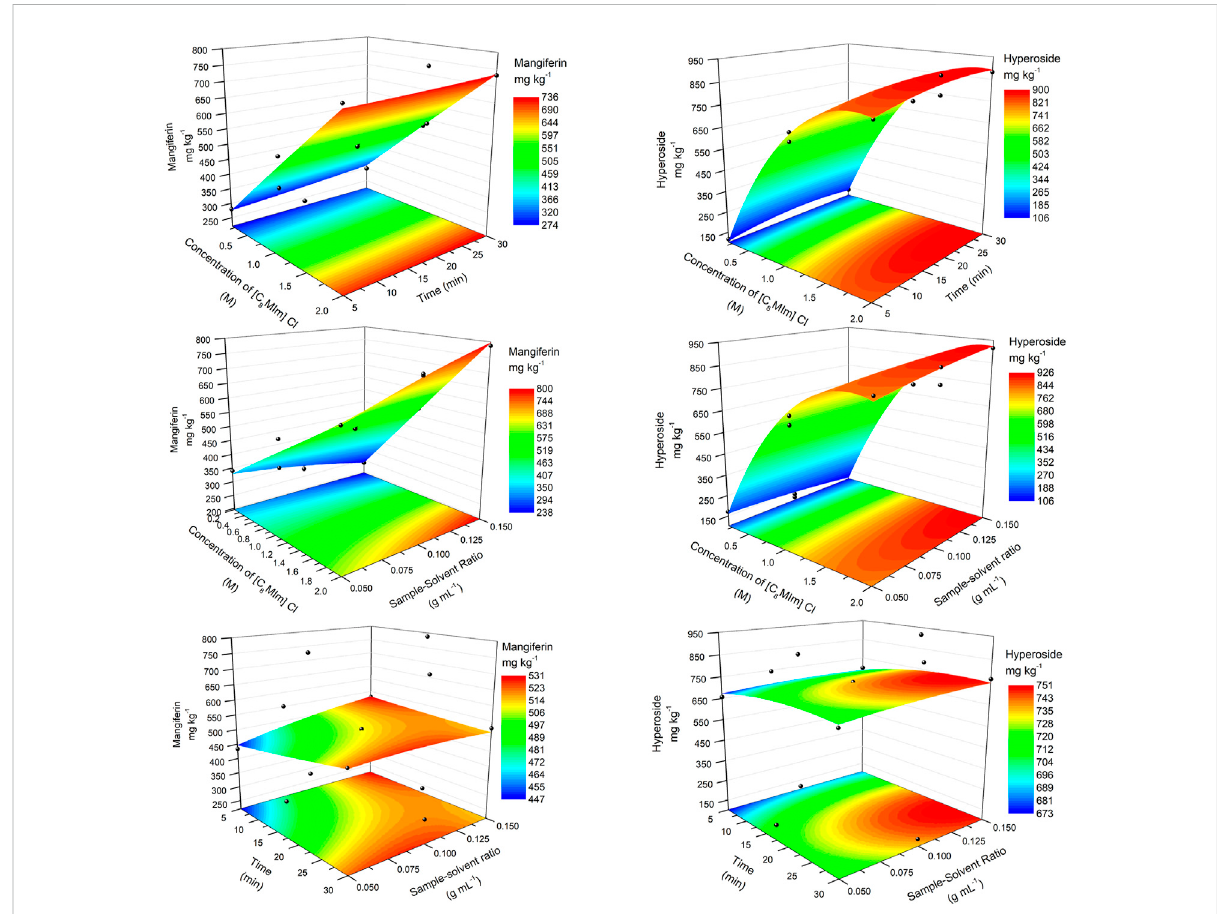
FIGURE 2 RSM plots for the optimization of the extraction of mangiferin (left) and hyperoside (right) using [C 8 MIm] Cl ionic